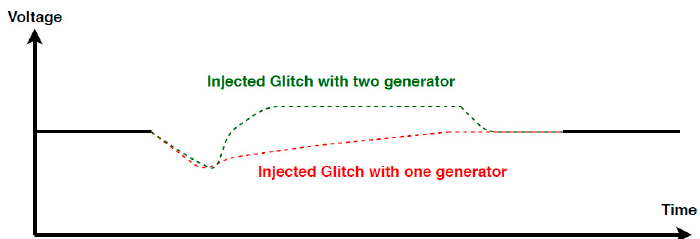
Figure 17. Comparing generated voltage signal with one and two voltage generators [44].